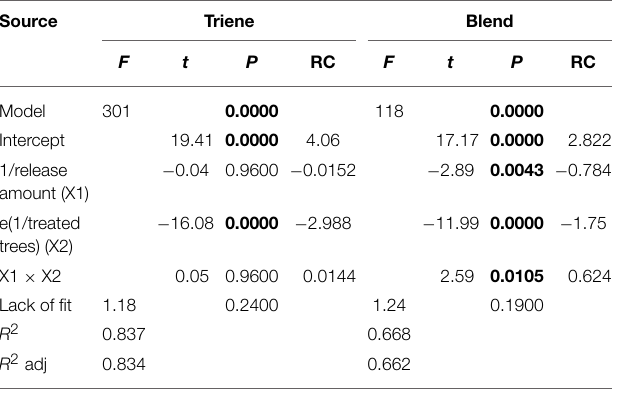
TABLE 3 | ANOVA and model diagnostics for trap catch disruption response surfaces for both the 3:1 triene: diene blend (attractive blend) and triene only (non-attractive blend) treatment.